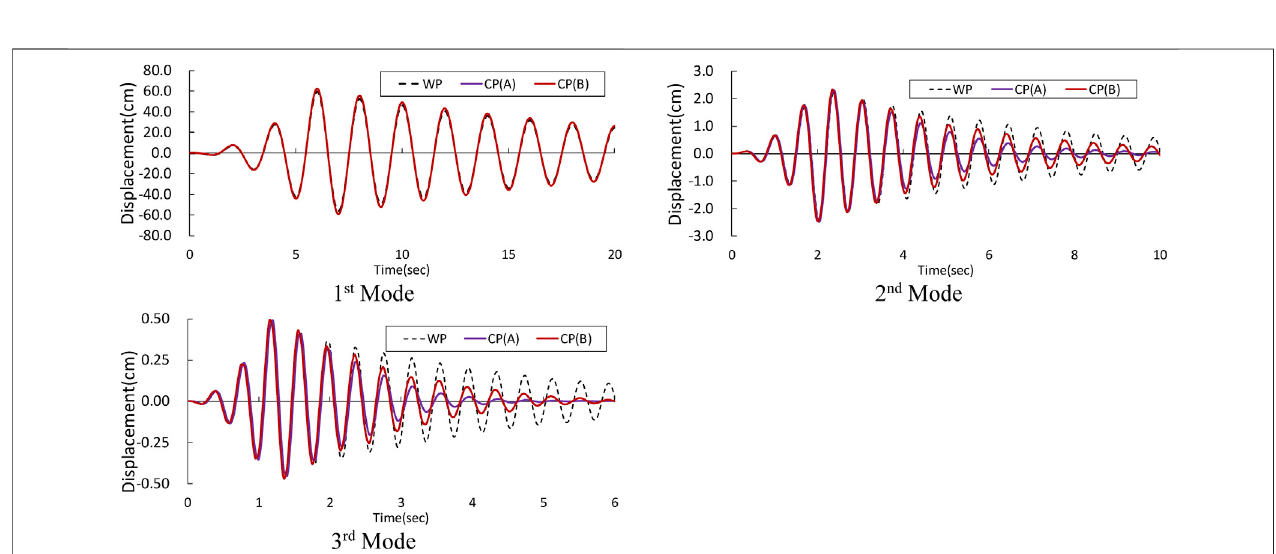
FIGURE 6 | Maximum response for the sinusoidal wave. (A) Input acceleration, (B) wave period = 2.000 s, (C) wave period = 0.679 s, (D) wave period = 0.394 s.